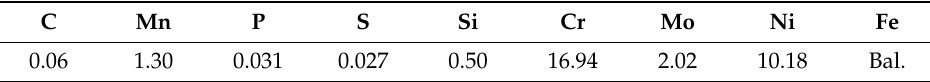
Table 3. Chemical composition of 316 stainless steel (wt %).